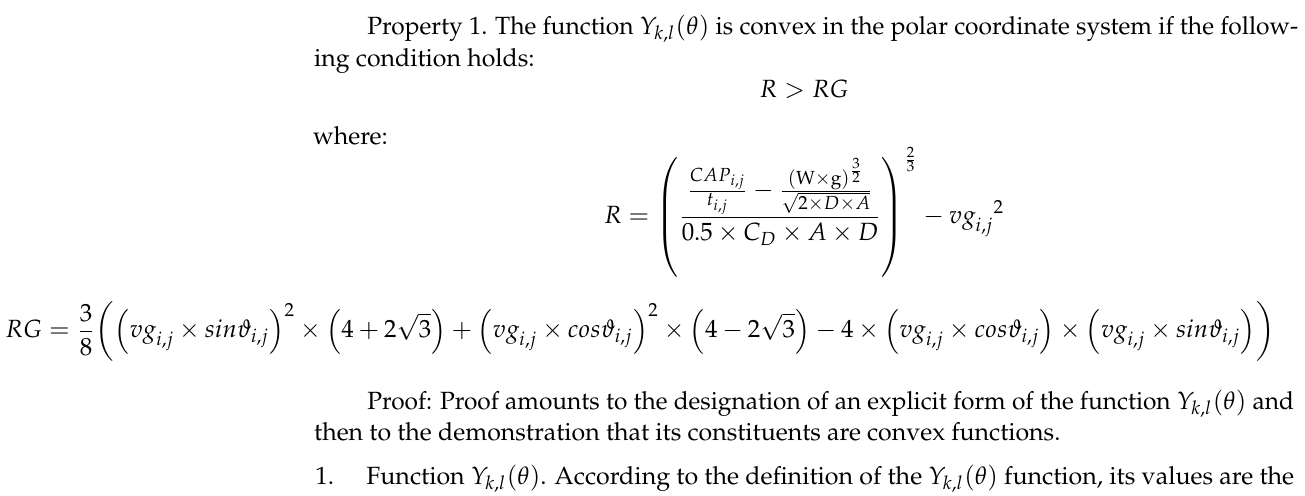
Figure 4. Example of a convex function in the polar coordinate